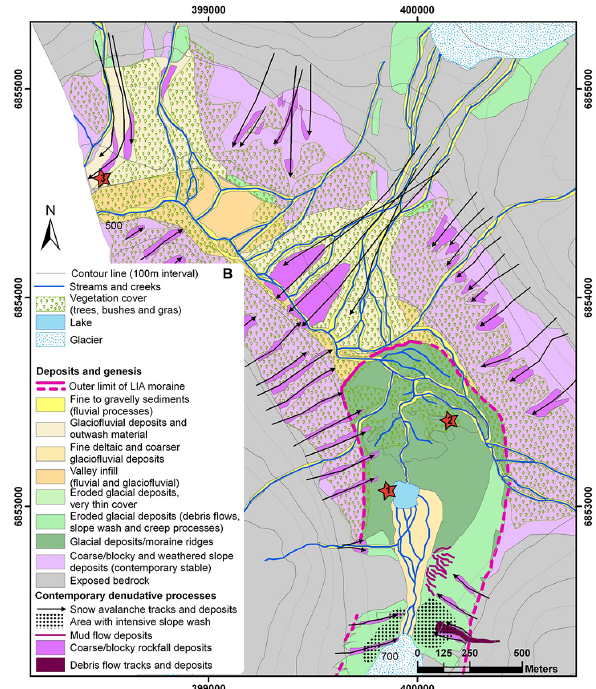
Figure 3. Geomorphological map of the Bødalen drainage basin (modified after Laute and Beylich, 2012) and location of the study profiles 1) PB1, 2) PB2 and 3)